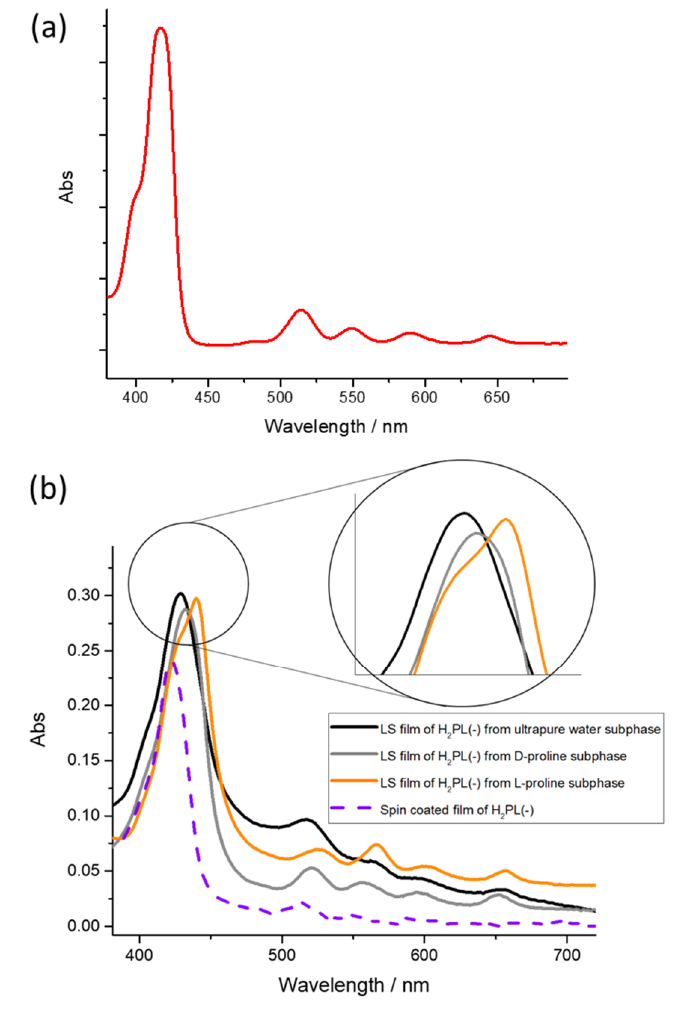
Figure 3. Absorption spectra of ( a ) dichloromethane solution of H 2 PL(-) and ( b ) LS films of H 2 PL(-) transferred from pure water subphase, D-proline and L-proline containing subphase (black, gray and orange spectra, respectively). A magnification of the Soret band in the three different situations is reported in the inset. Dotted line represents the UV-visible spectrum of H 2 PL(-) transferred by spin-coating